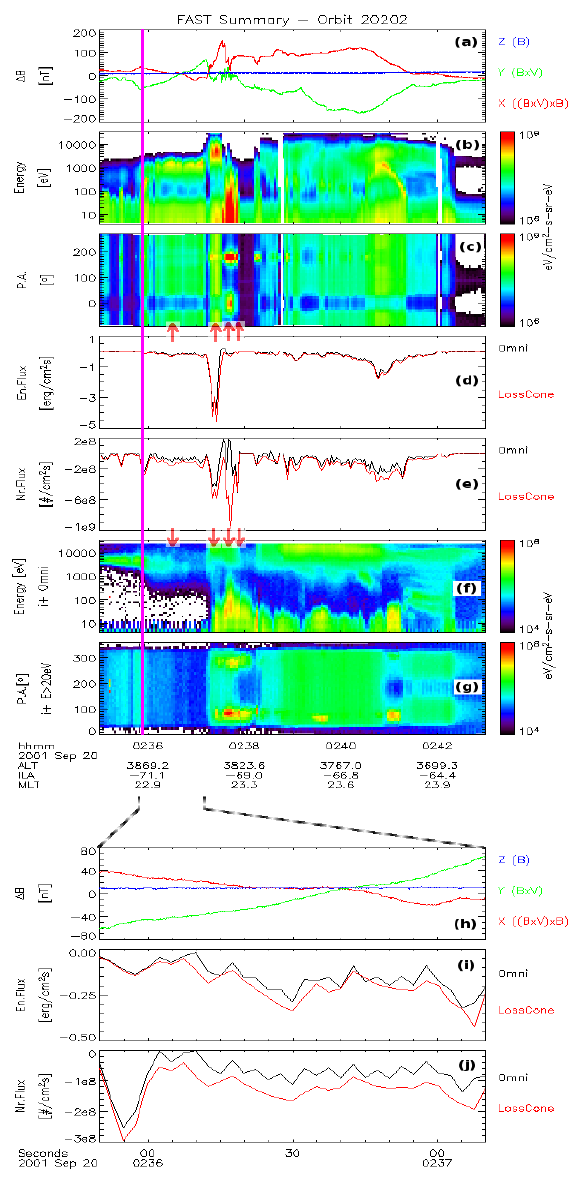
Fig. 5. Top: summary of FAST data: Magnetic field perturbation (a) , electron data (b–e) , and ion data (f, g) . The electron panels show: EESA energy and pitch-angle spectrograms (b, c), energy and number flux (d, e). The energy and number fluxes are obtained by summing over electrons above 50eV, omnidirectional (black) and within the loss-cone (red). For the ions we show IESA energy and pitch-angle spectrograms (f, g). The vertical magenta line indicates the conjunction with Cluster, while the arrows below panel (c) and above panel (f) indicate the times of the distribution functions in Fig. 6. Bottom: zoom in on 80s of data near the polar cap: Magnetic field perturbation (h) , energy flux (i) , and number flux (j) . These data are reasonably consistent with a current sheet geometry, almost parallel (within ∼ 15 ◦ ) to the magnetic E–W